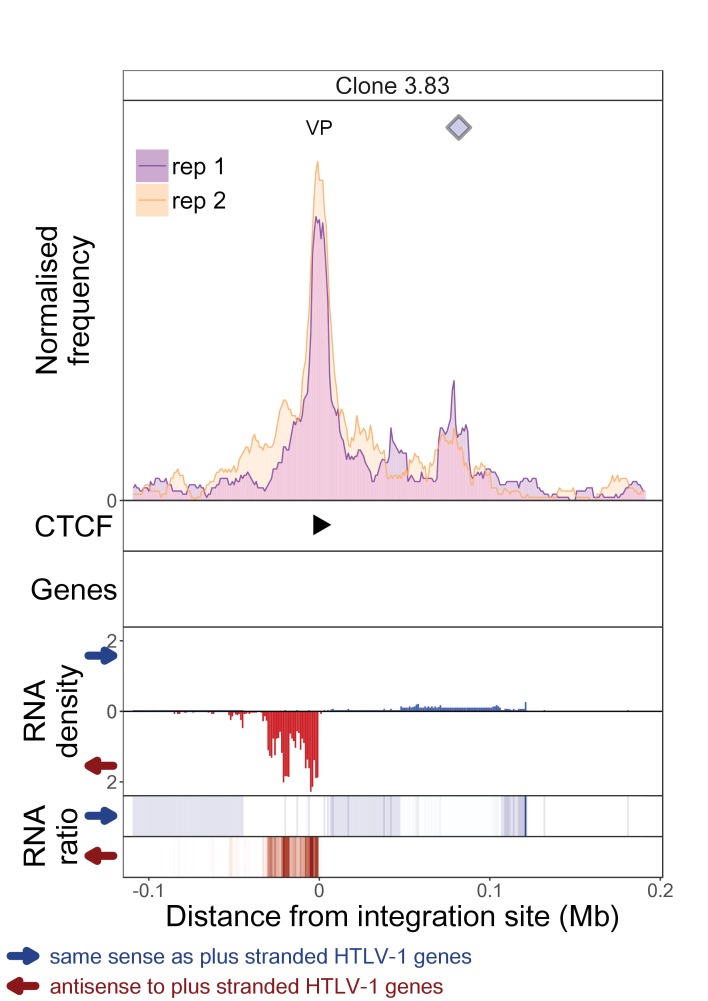
q4C and RNASeq data aligned – clone 3.83.See legend for Figure 1—figure supplement 1.